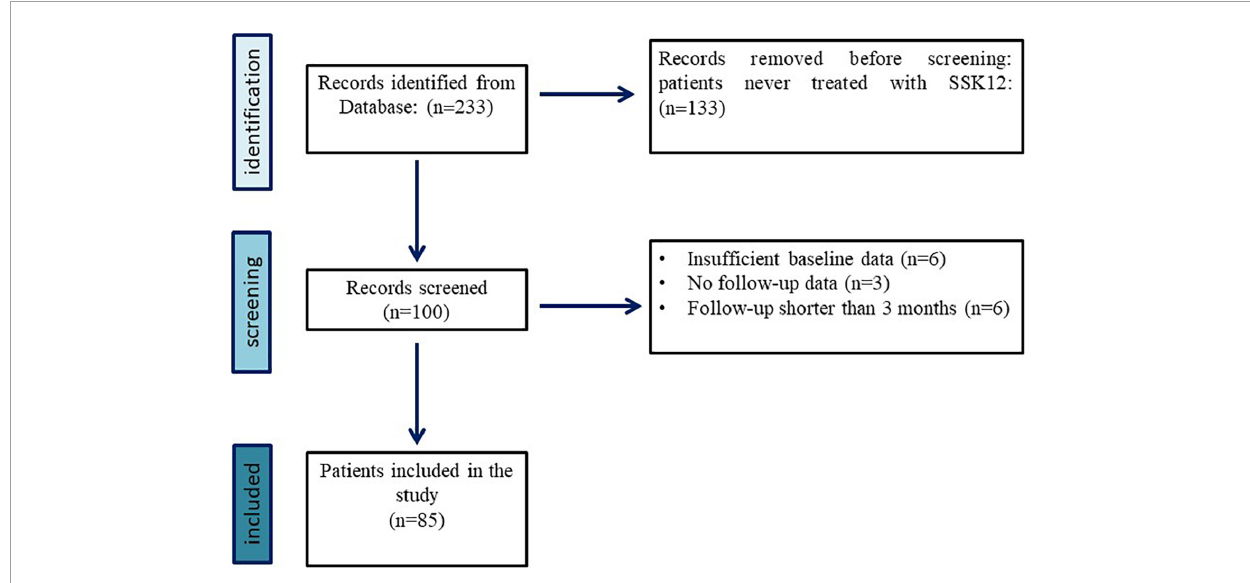
FIGURE1 Selection process of eligible patients with PFAPA syndrome enrolled in the AIDA registry, forming the final cohort of participants in our